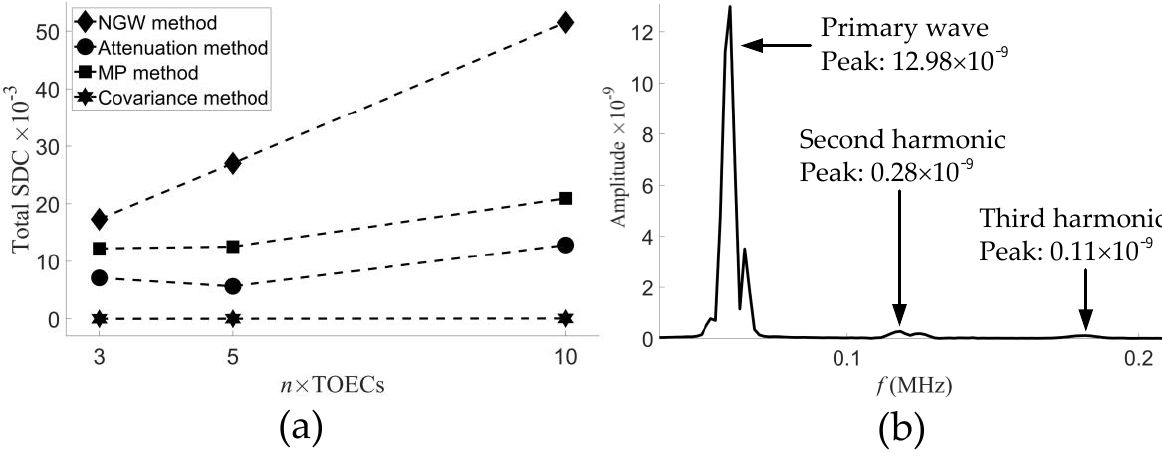
Figure 9. ( a ) The peak values of total SDC of the three degradations as a function of the TOECs. ( b ) The primary wave, second and third harmonic in the frequency spectrum of the signals received by the opposite sensor.